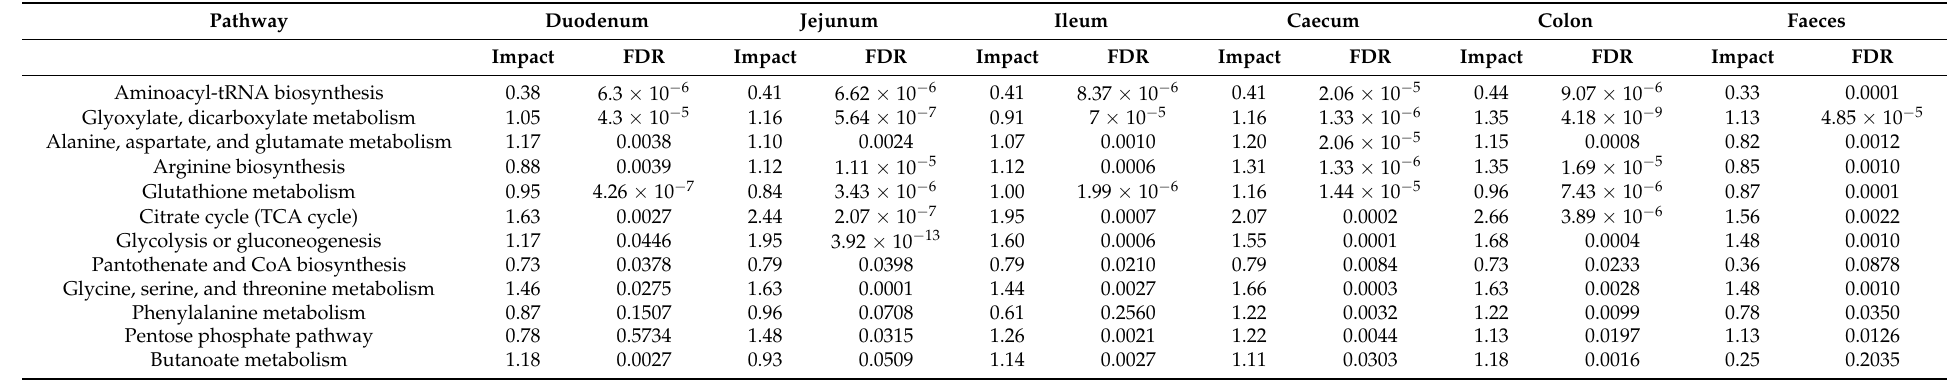
Table 1. Major statistically significant pathways contributing towards the mouse gut metabolism during giardiasis, as determined by the joint pathway